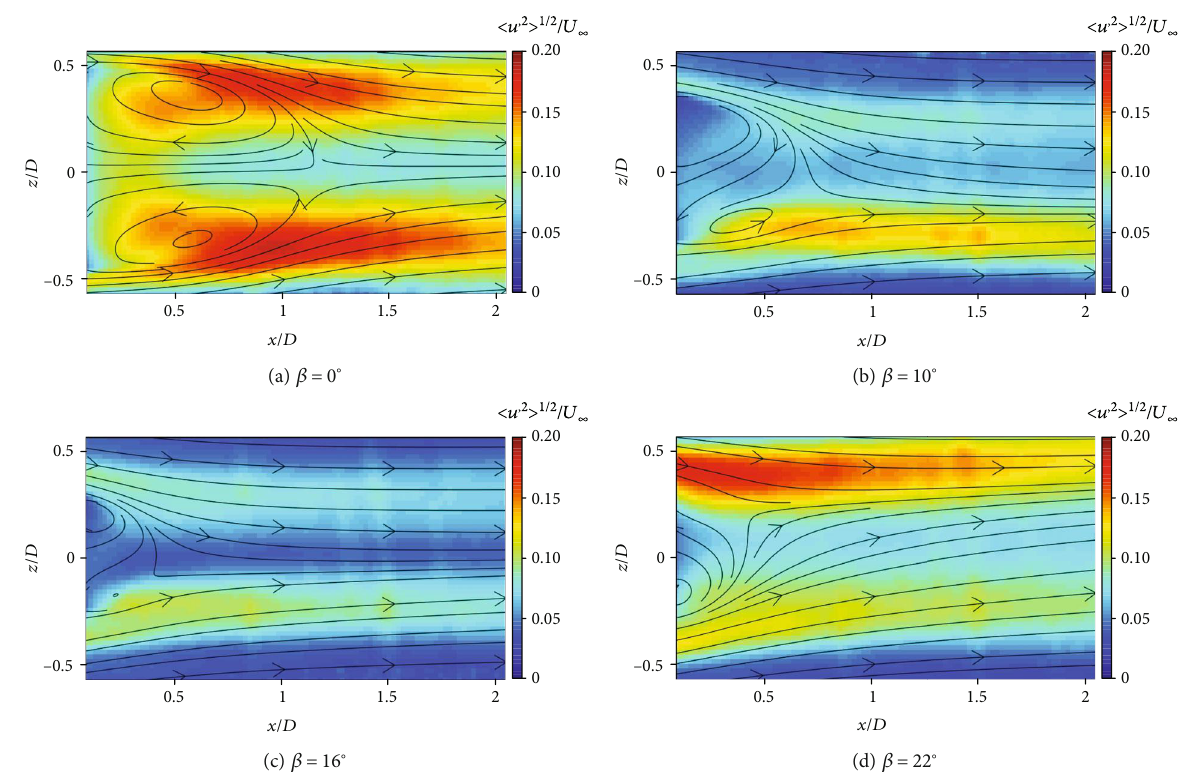
Figure 10: Streamwise turbulence level < u ,2 > 1/2 at di ff erent boattail angles (a) β = 0 ° , (b) β = 10 ° , (c) β = 16 ° , and (d) β = 22 ° .